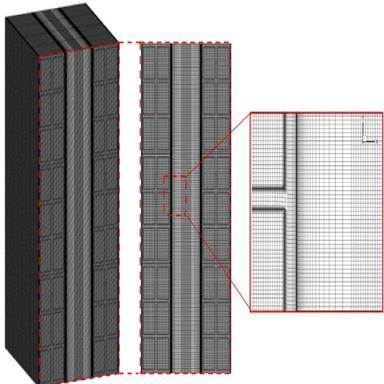
The grid system of the studied wall.